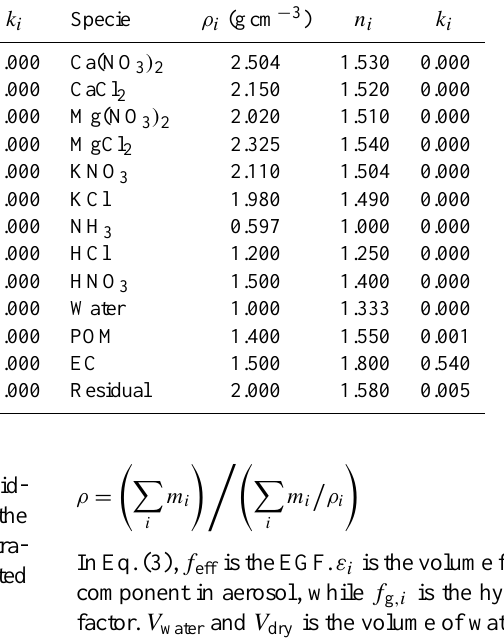
Table 2. Summary of the parameters for calculating the EORI and EGF.